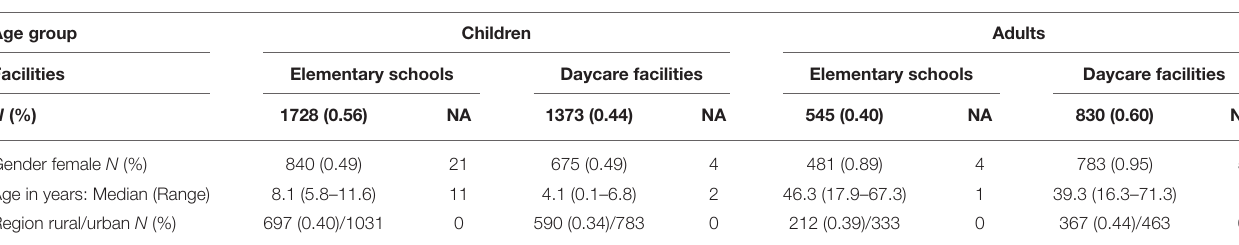
TABLE 1 | Population characteristics by study group.